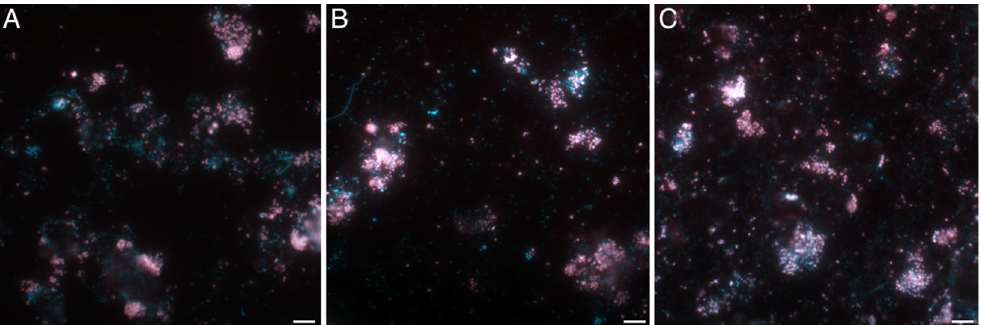
Figure 6. FISH micrographs of biomass collected from the column reactor at days 83 ( A ), 200 ( B ) and 280 ( C ). FISH was performed with Alexa Fluor 647-labelled EUB338mix probe (cyan) for all bacteria, and an Alexa Fluor 555-labelled Sca1129b probes (red) for Ca . Scalindua. Ca. Scalindua appears magenta and other bacteria appear blue. Scale bars represent 10 µm.